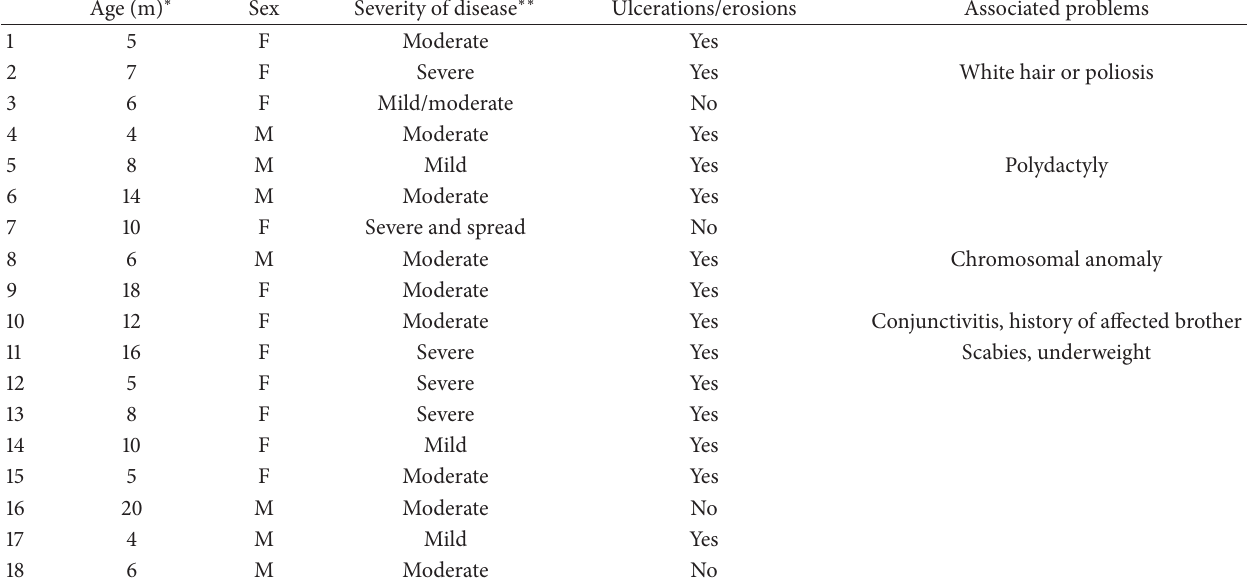
Table 1: Mean features of the